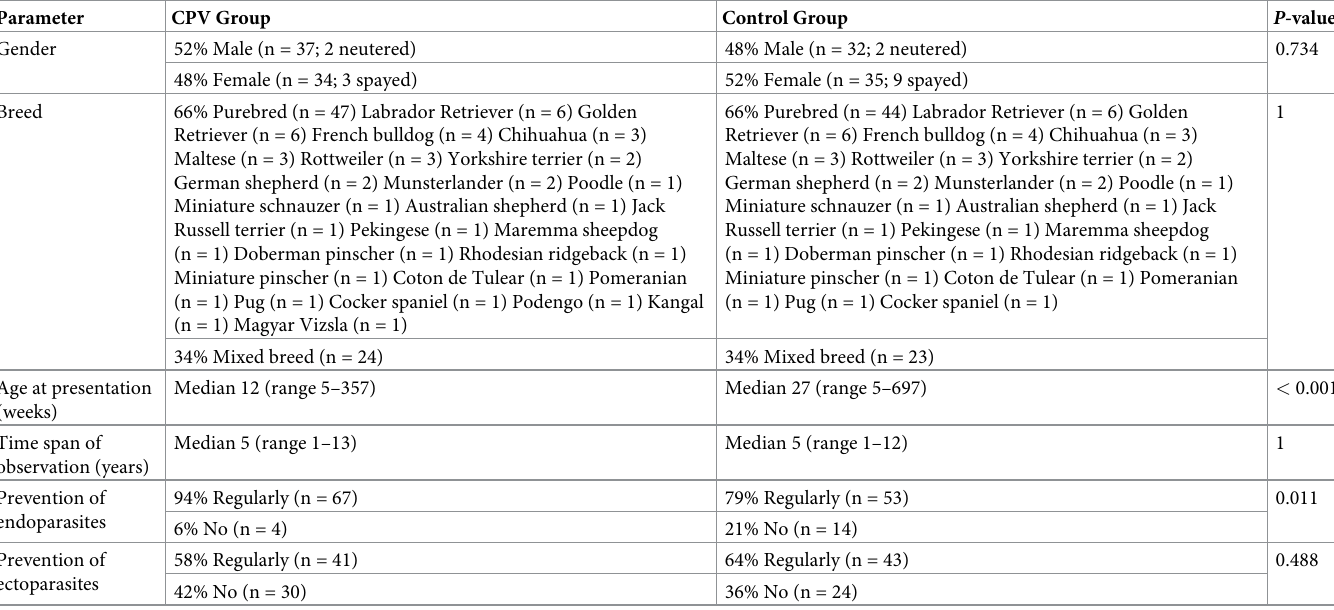
Table 1. Signalement and basic information of dogs of the CPV and control group. Parameter